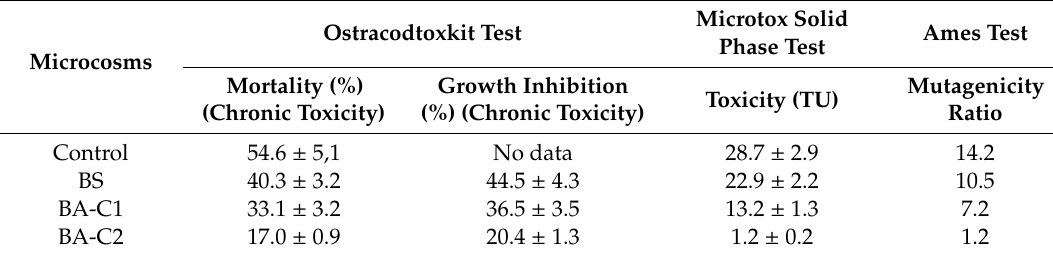
Figure 2. Inhibition of ( A ) root growth and ( B ) seed germination in the analyzed soil microcosms. Thedataarepresentedasthemeanvalues ± SD( n = 4). Control: untreatedmicrocosms, BS:biostimulated microcosms, BA-C1 and BA-C2: microcosms bioaugmented with the bacterial community C1 and the mixed culture C2, respectively. Table 4. Bioassay